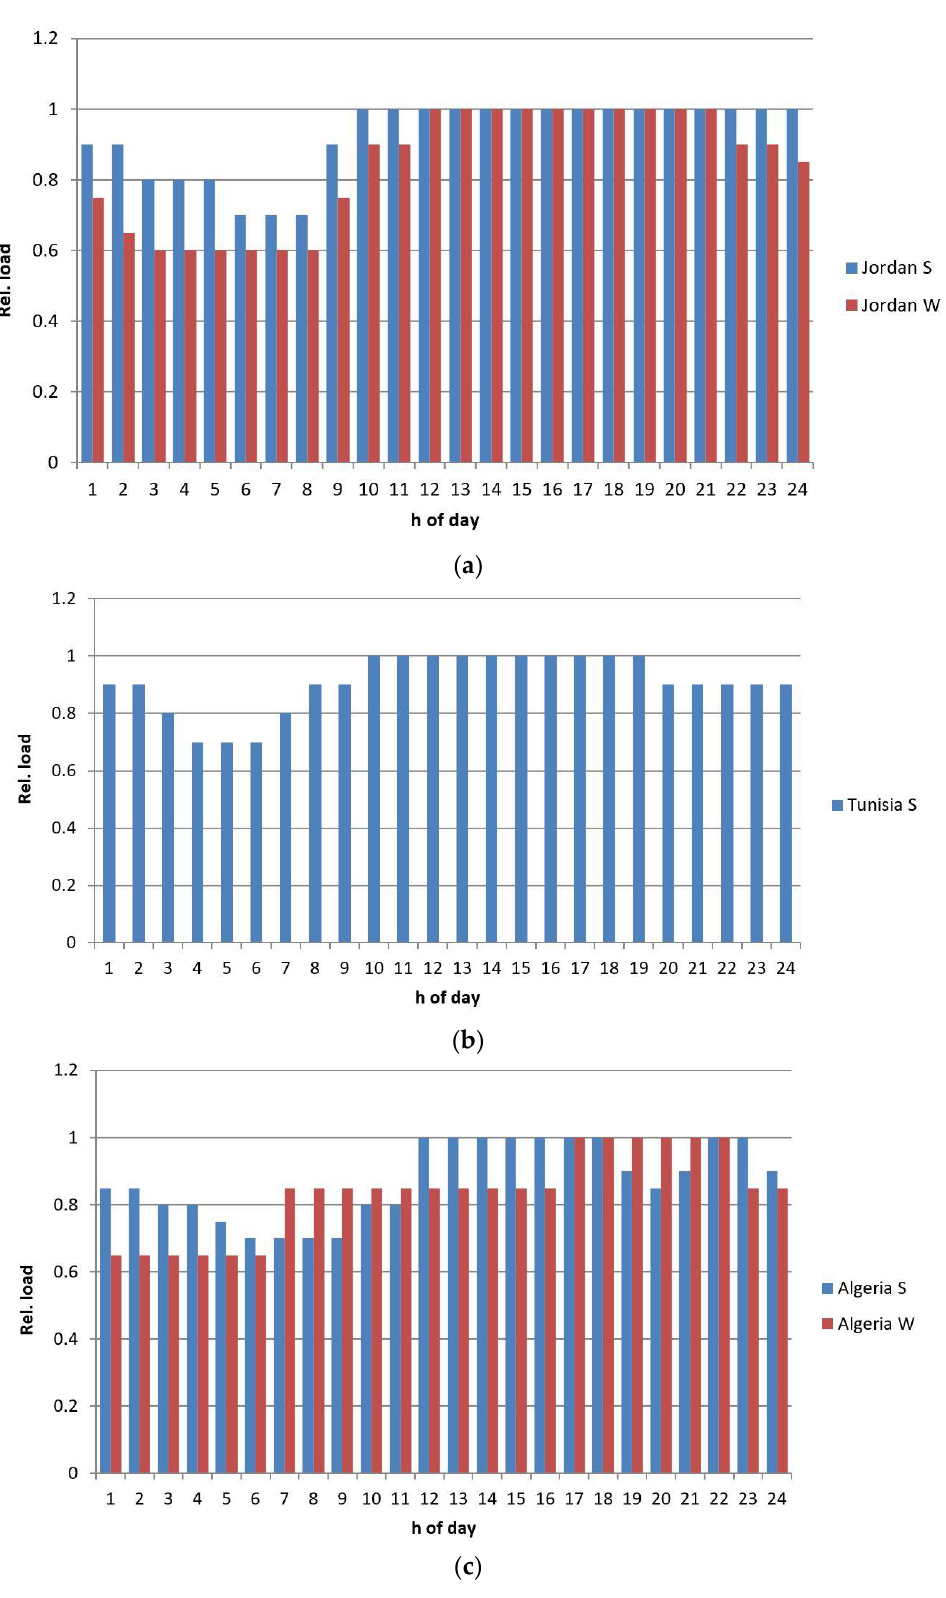
Figure 4. Demand profile for: ( a ) Ma’an, Jordan, ( b ) Tataouine, Tunisia and ( c ) Ghardaia, Algeria for summer “S” and winter W”. Source: HYMENSO partners .